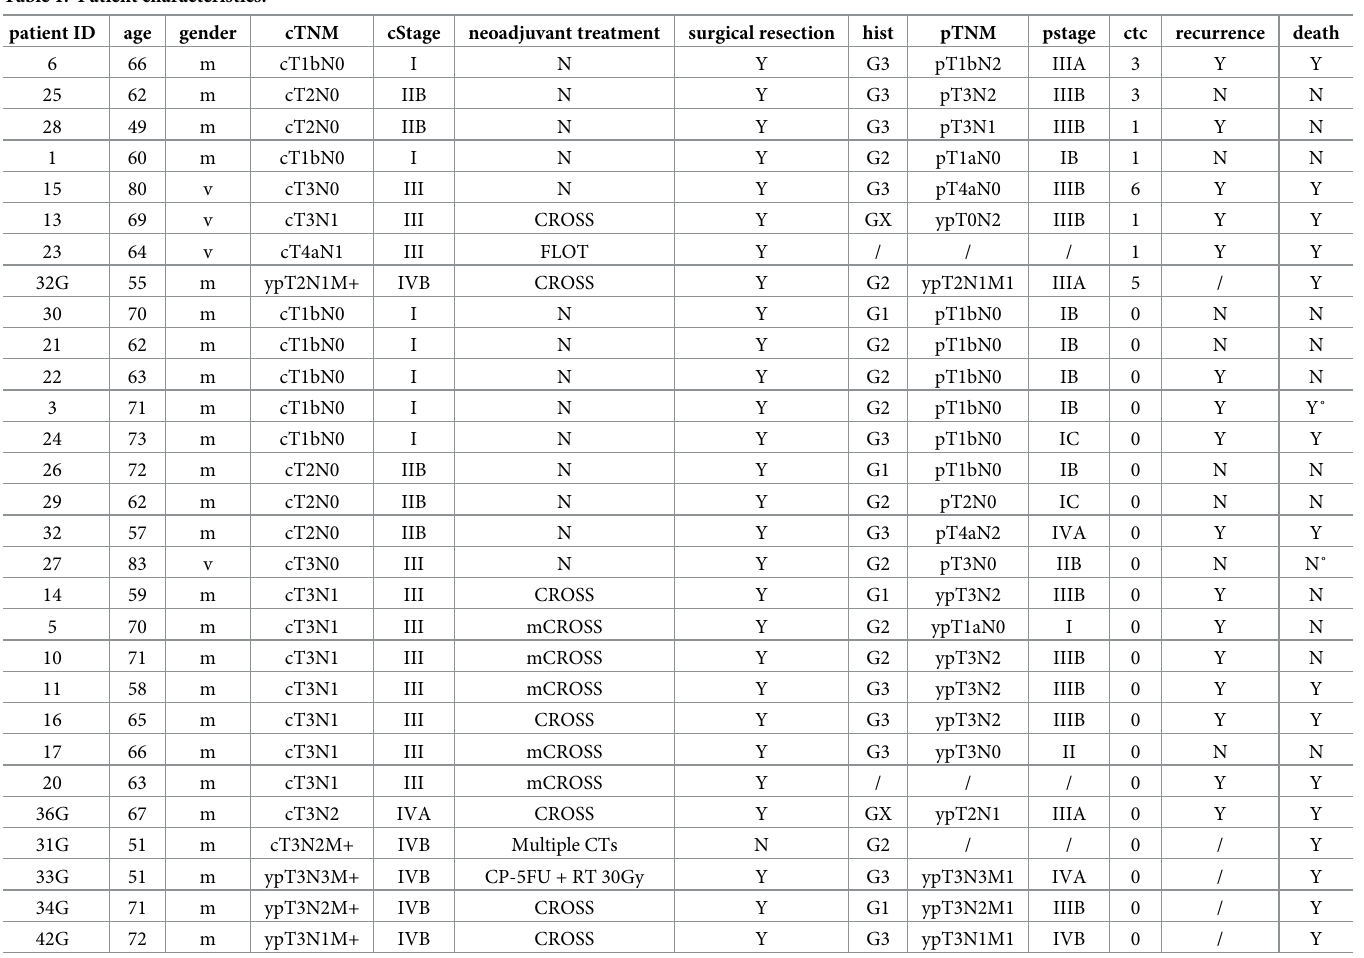
Table 1. Patient